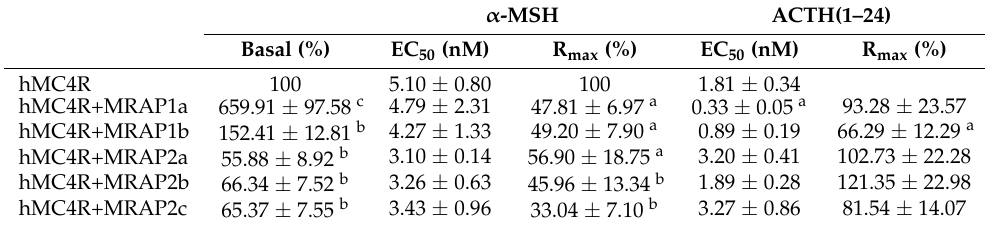
Values are expressed as the mean ± SEM of at least three independent experiments. a Significant difference from the parameter of hMC4R, p < 0.05. Table 4. The signaling properties of hMC4R regulated by hMRAP1s and hMRAP2s.